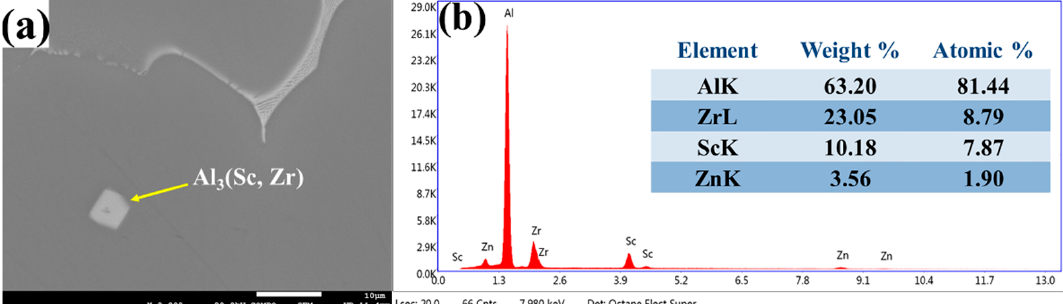
Figure 4. SEM microstructures of squeeze castings of the test alloy under two conditions: ( a ) Without ESMT; ( b ) With ESMT.